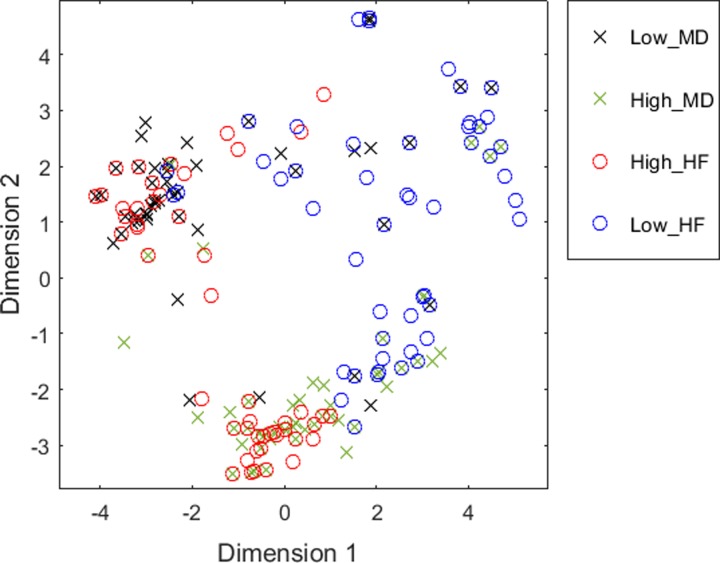
Multidimensional scaling plot of the distances between the Mechanisms of Action (MoA) of the four groups defined.Each point represents a MoA. Axes are defined by the most representative dimensions.